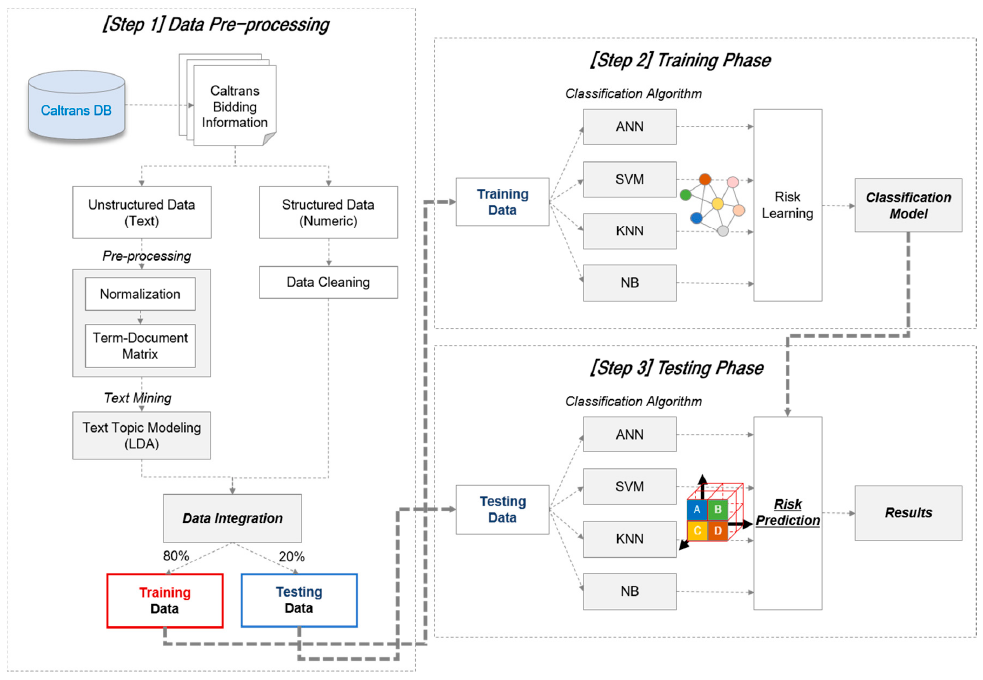
Figure 3. Research model process.